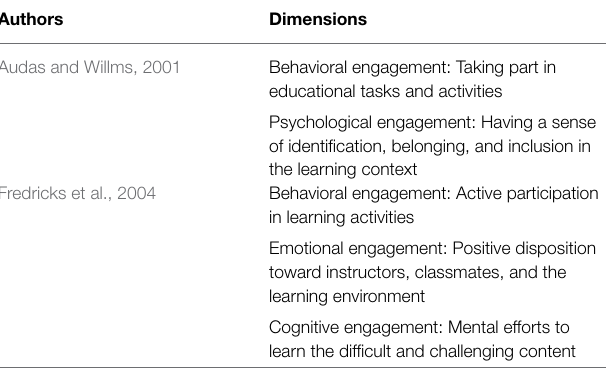
TABLE 1 | Different dimensions of academic